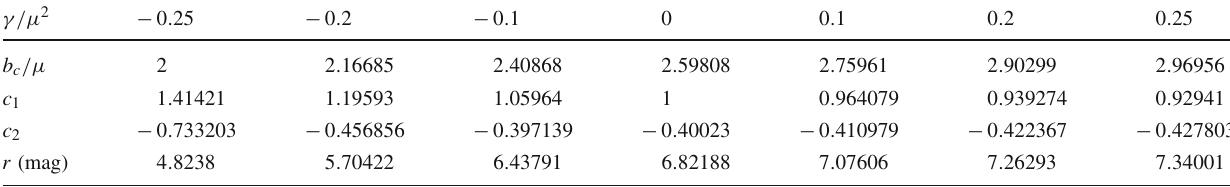
Table 1 Numerical values of the quantities that are independent of the distance to the black hole: the critical impact parameter b c /μ , the coefficients c 1 and c 2 , and the observable r (converted to magnitudes), for some representative values of γ/μ 2 γ/μ 2 − 0 .